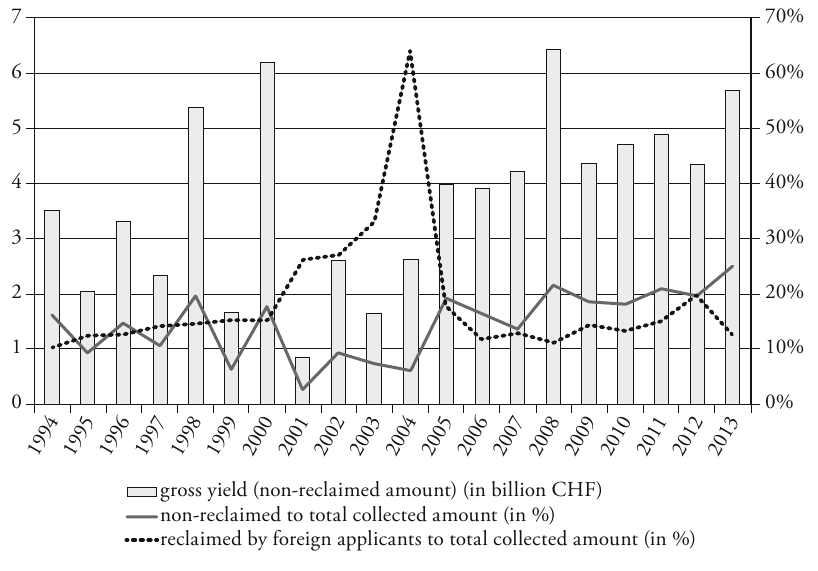
Figure 3: Withholding Tax Figures for Switzerland for the Time Period 1994 to